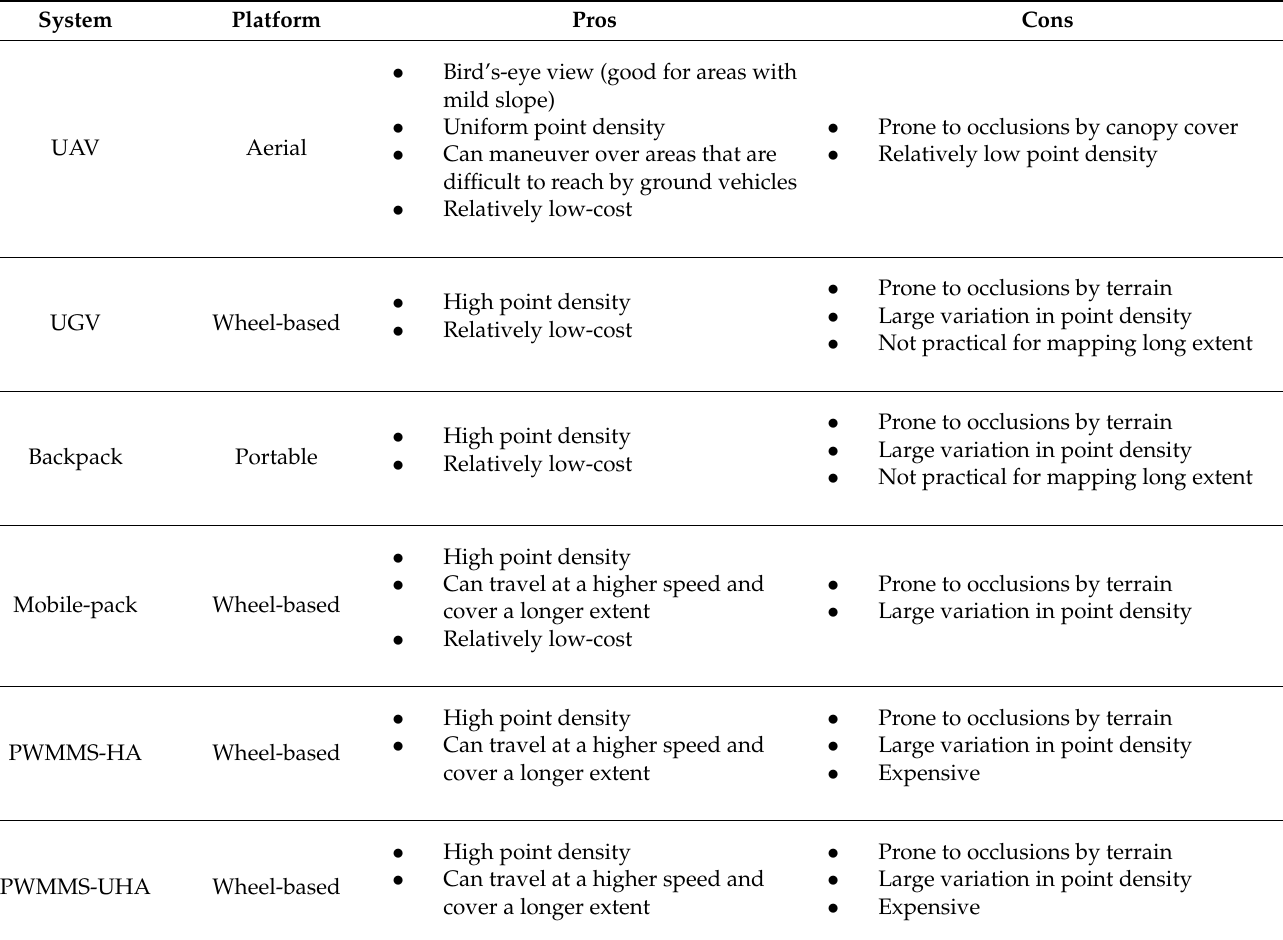
Table 10. Comparison of different MLMS units showing their merits and